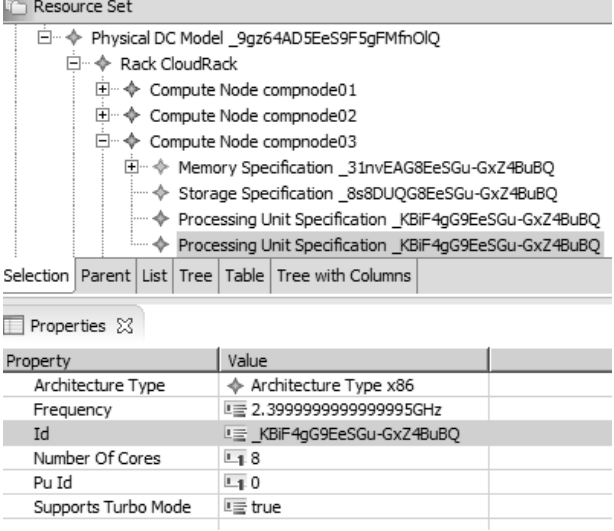
Figure 5. Interaction between CactoSim and runtime model storage.